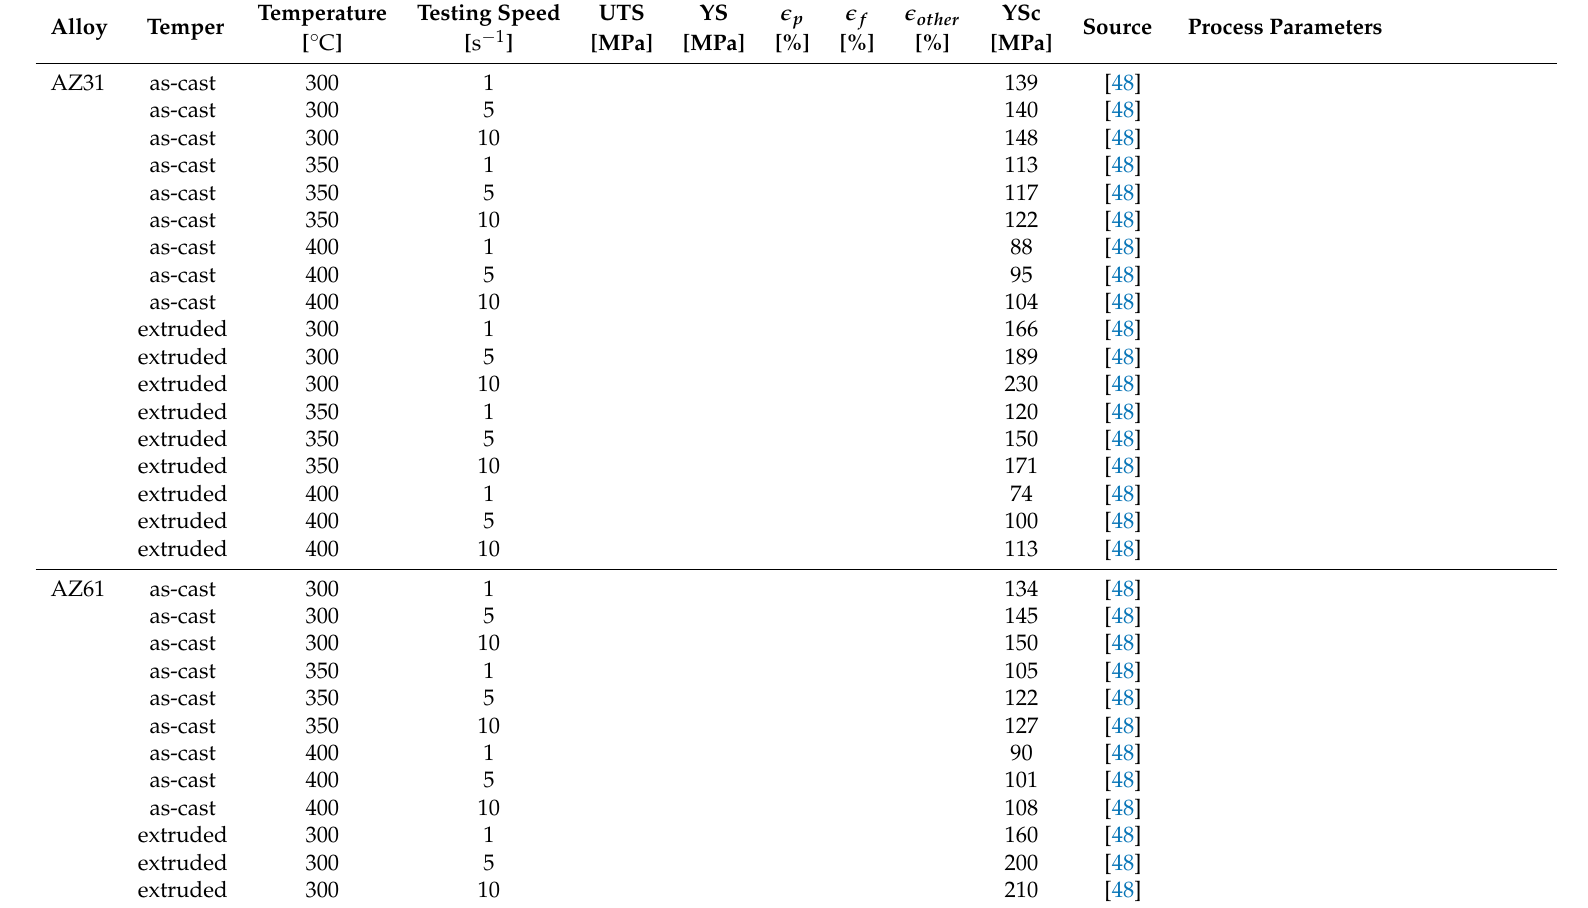
Table A6. Mechanical properties of Mg alloys tested at elevated